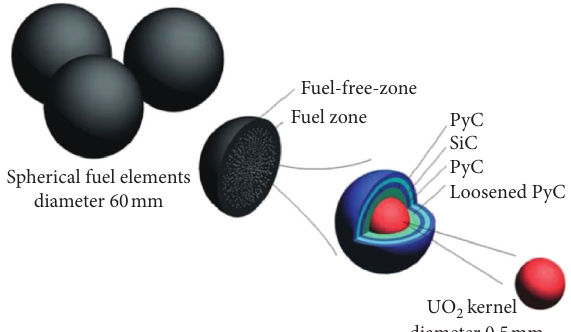
Figure 1: The spherical fuel element of HTGR.